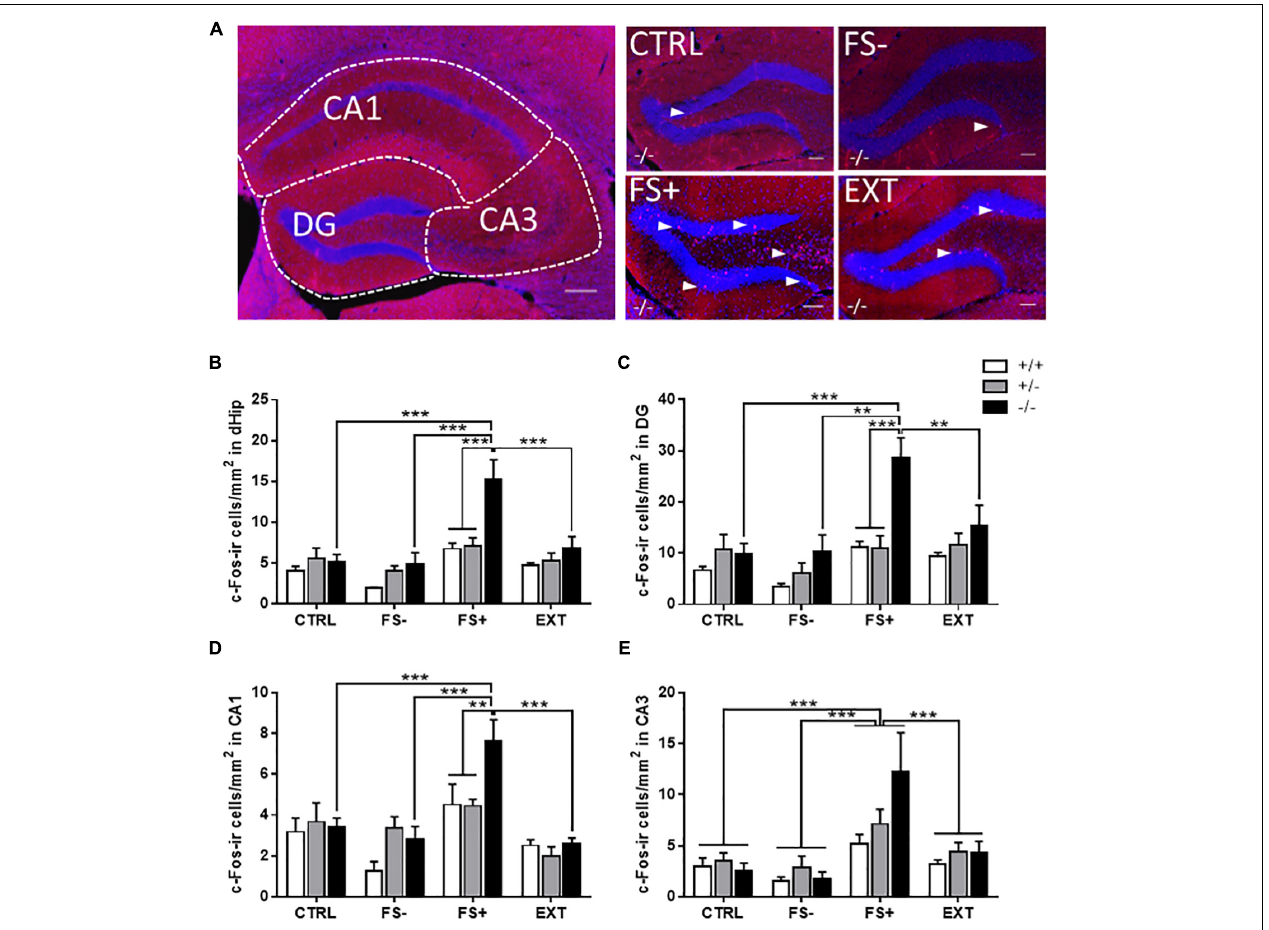
FIGURE 3 | Increased c-Fos activity in the dorsal hippocampus (dHip) of Tph2 − / − mice following fear conditioning. ( A , left panel) Overview of the dHip indicating the subregions dentate gyrus (DG), cornu ammonis area 1 (CA1), and cornu ammonis area 3 (CA3) and ( A , right panel) higher magnification images depicting the DG of representative Tph2 − / − mice for the different groups: home cage controls (CTRL), context controls subjected to the conditioning procedure without foot shocks (FS–), fear-conditioned mice receiving three tone-signaled foot shocks (FS+), fear-conditioned mice that underwent two extinction training sessions (EXT). Quantification of c-Fos-ir cell densities in (B) the total dHip, (C) DG, (D) CA1, and (E) CA3 of Tph2 + / + , Tph2 + / − , and Tph2 − / − mice of the four different groups. Arrowheads in (A) indicate c-Fos-ir cells (red), DAPI-stained cell nuclei (blue). Scale bars in (A) : 200 µ m (left panel) and 100 µ m (right panel). Data are shown as means + SEM. ∗∗ p < 0.01; ∗∗∗ p <